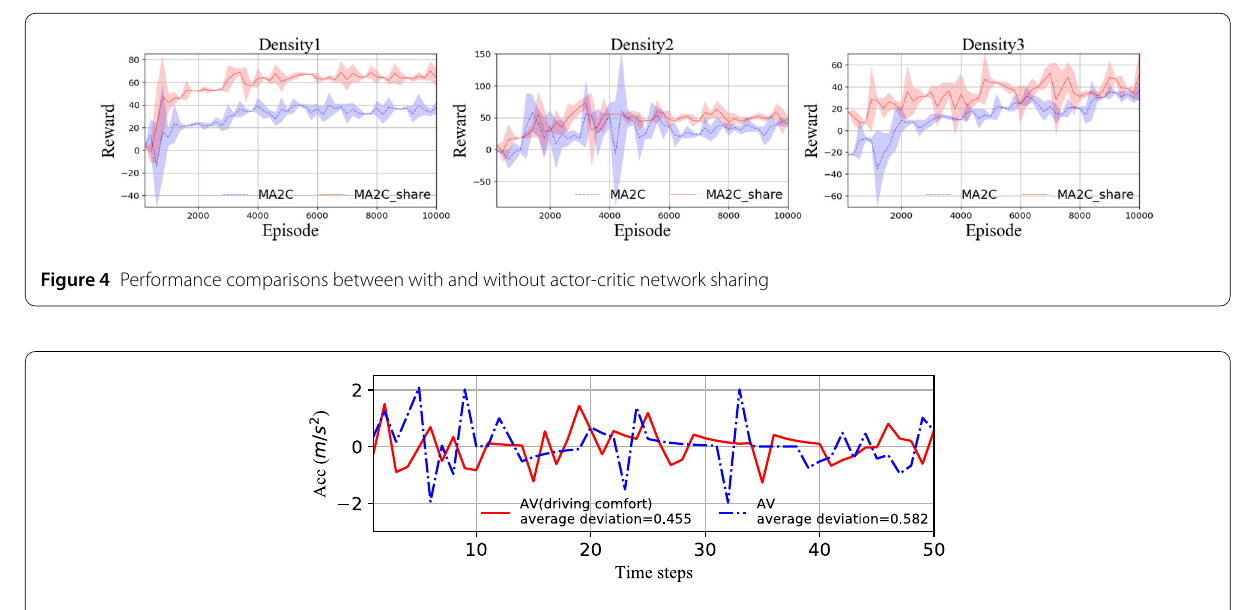
Figure 5 Performance comparisons of acceleration between the reward design with or without comfort measurement